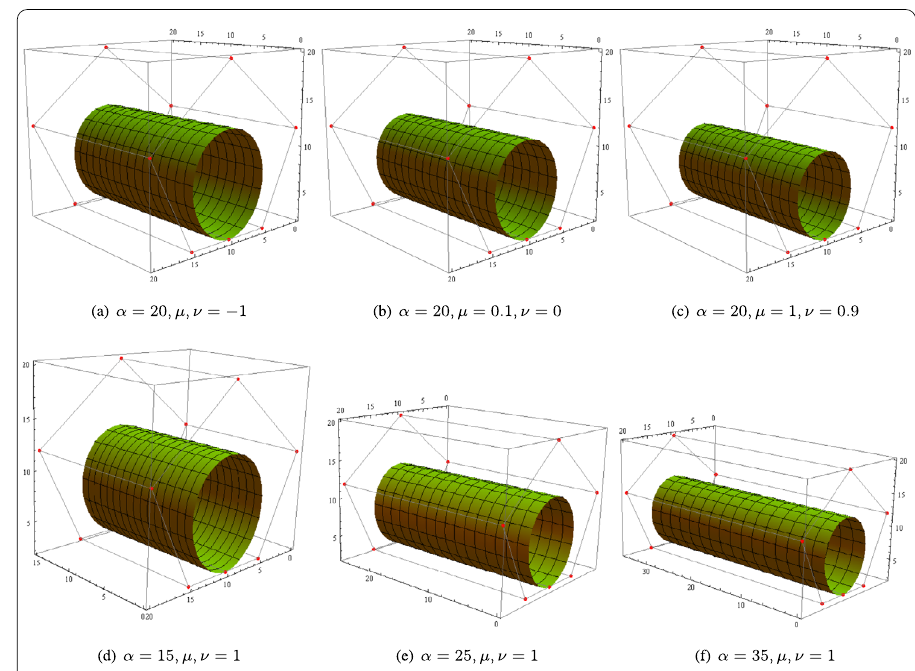
Figure 5 GBT-Bézier cylinders with different values of μ , ν , and α